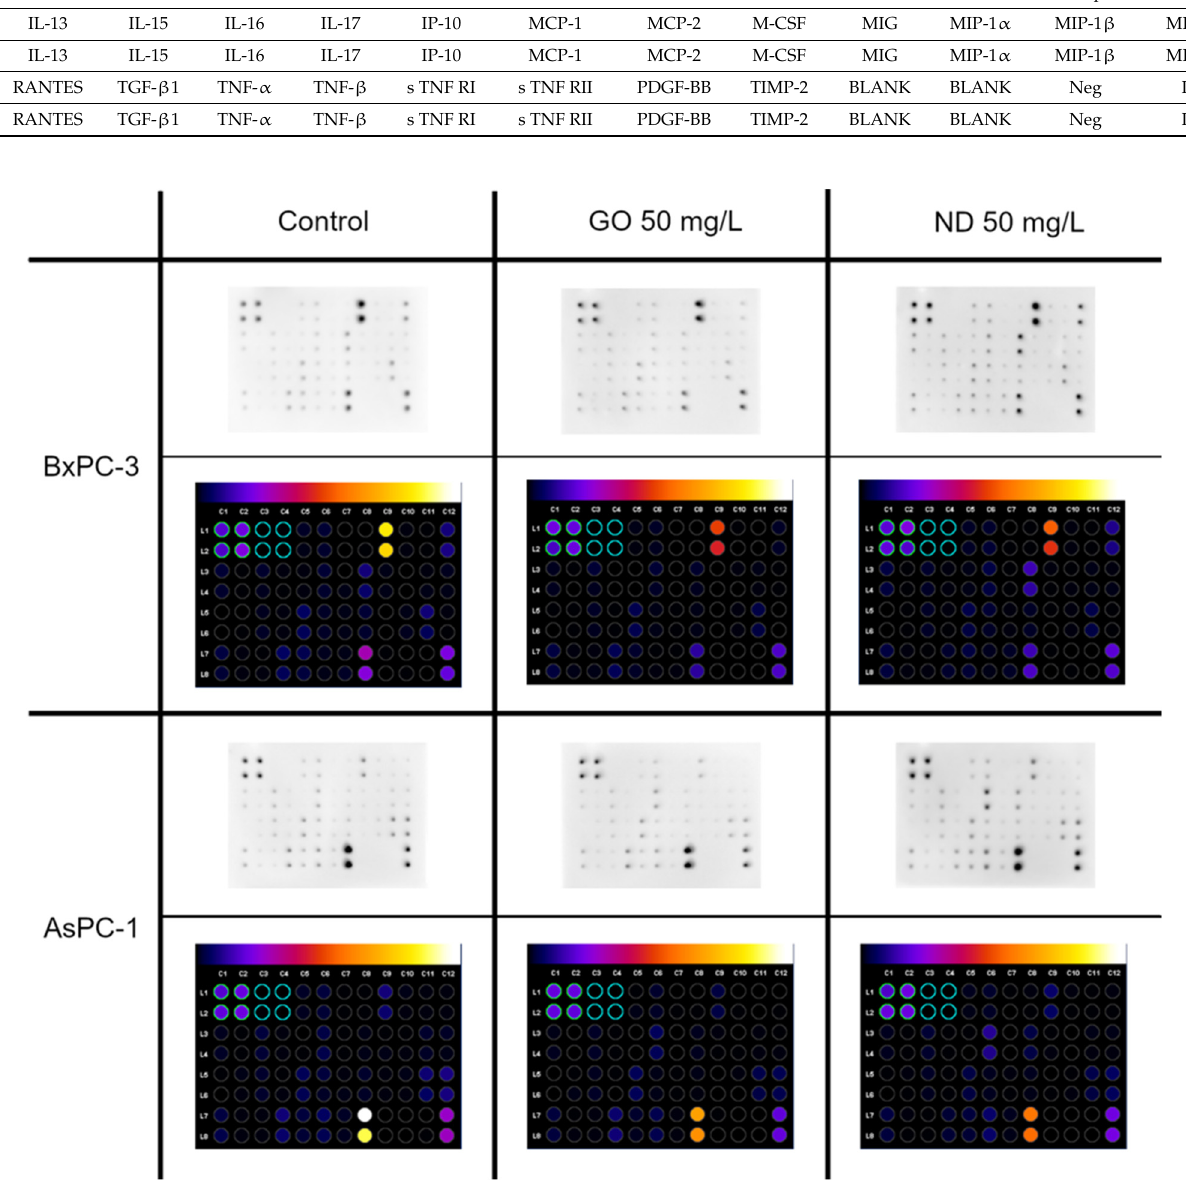
Figure 11. Pro-inflammatory protein expression after 24 h of incubation of the AsPC-1 and BxPC-3 cell lines with ND and GO, at a concentration of 50 mg/L, as determined by the human inflammation antibody array-membranes. The control group was treated with the same volume of ultrapure water. The results are normalized to the control groups. Images were created with ImageJ software.